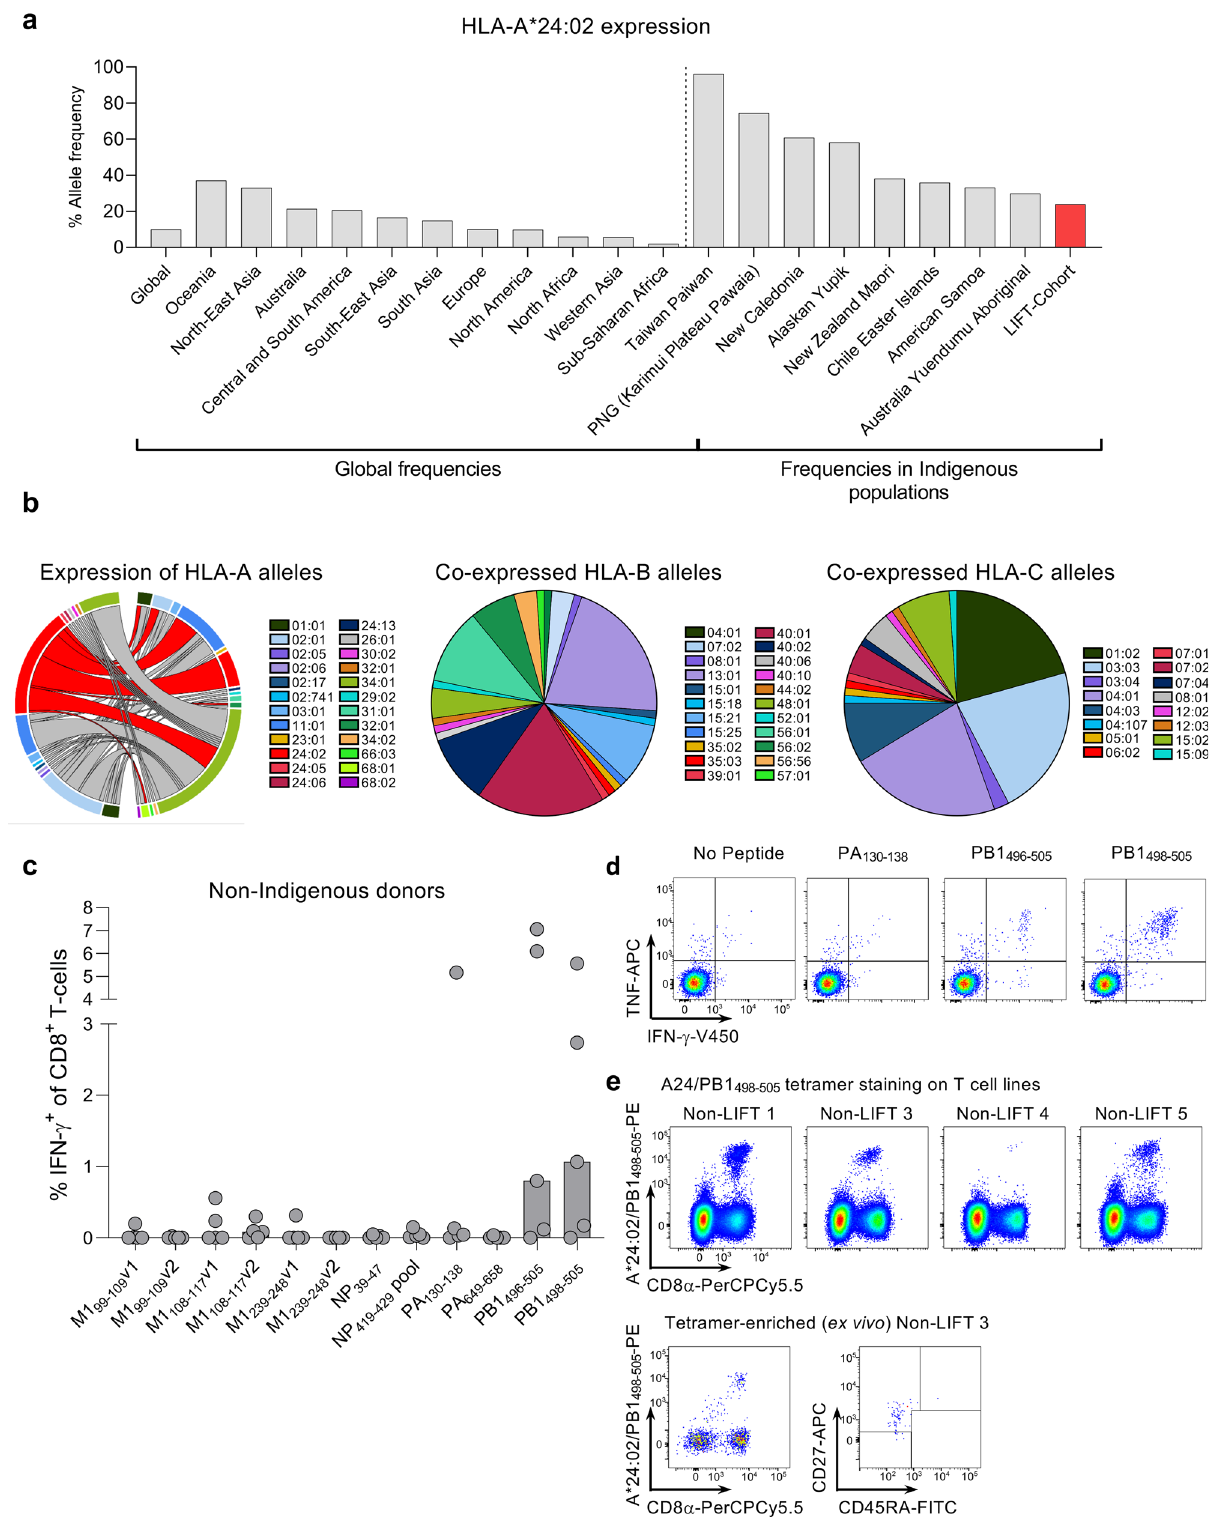
Fig. 1 HLA-A24 expression and characterization of published IAV epitopes. a Allele frequency of HLA-A*24:02 according to geographic region (left panel) and Indigenous population in the paci fi c region (right panel) (source www.allelefrequencies.net accessed 20/01/2020). b Co-expression of HLA-A, B and C alleles with the HLA-A*24:02 allele in the LIFT cohort, where Circos plot is shown for HLA-A and pie charts are shown for HLA-C and B alleles that are co-expressed with the HLA-A*24:02 allele. c Screening of previously identi fi ed IAV HLA-A*24:02 peptides via IFN- γ -ICS assay following peptide expansion of PBMCs from 5 non-Indigenous individuals (median bar graphs are shown). d Representative FACS plots of cytokine expression for immunogenic peptides. e A24/PB1 498 – 505 -tetramer staining of peptide-expanded T-cell lines (top panels) and after ex vivo TAME from non-LIFT 3 donor (bottom panels) showing the TAME-enriched population and